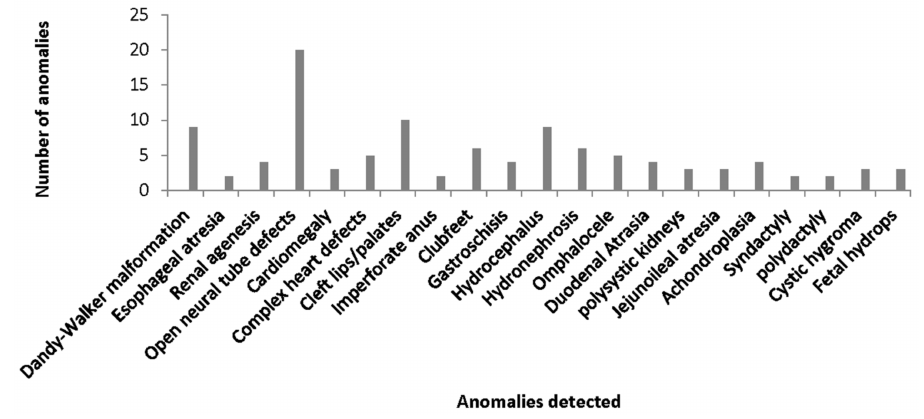
Figure 1. Distribution of anomalies detected. Table 1. Distribution of anomalies according to body